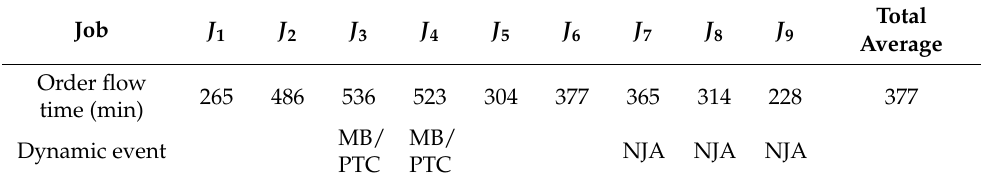
Table 9 . The order flow time simulation model results and dynamic event job affiliation.